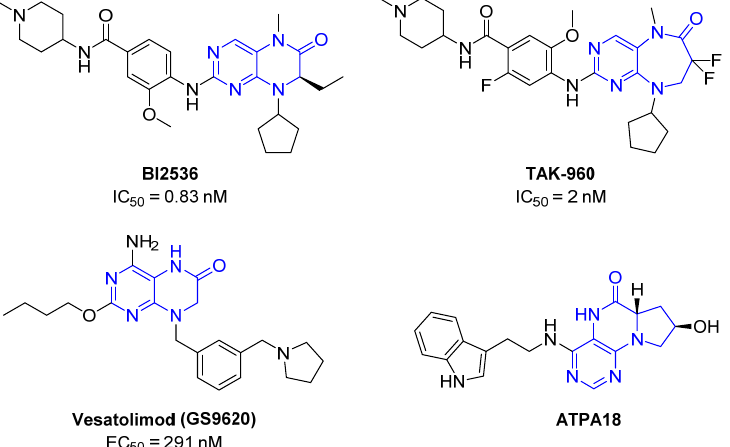
Figure 1. Representative examples of biologically active pteridinones and pyrimidodiazepinones.